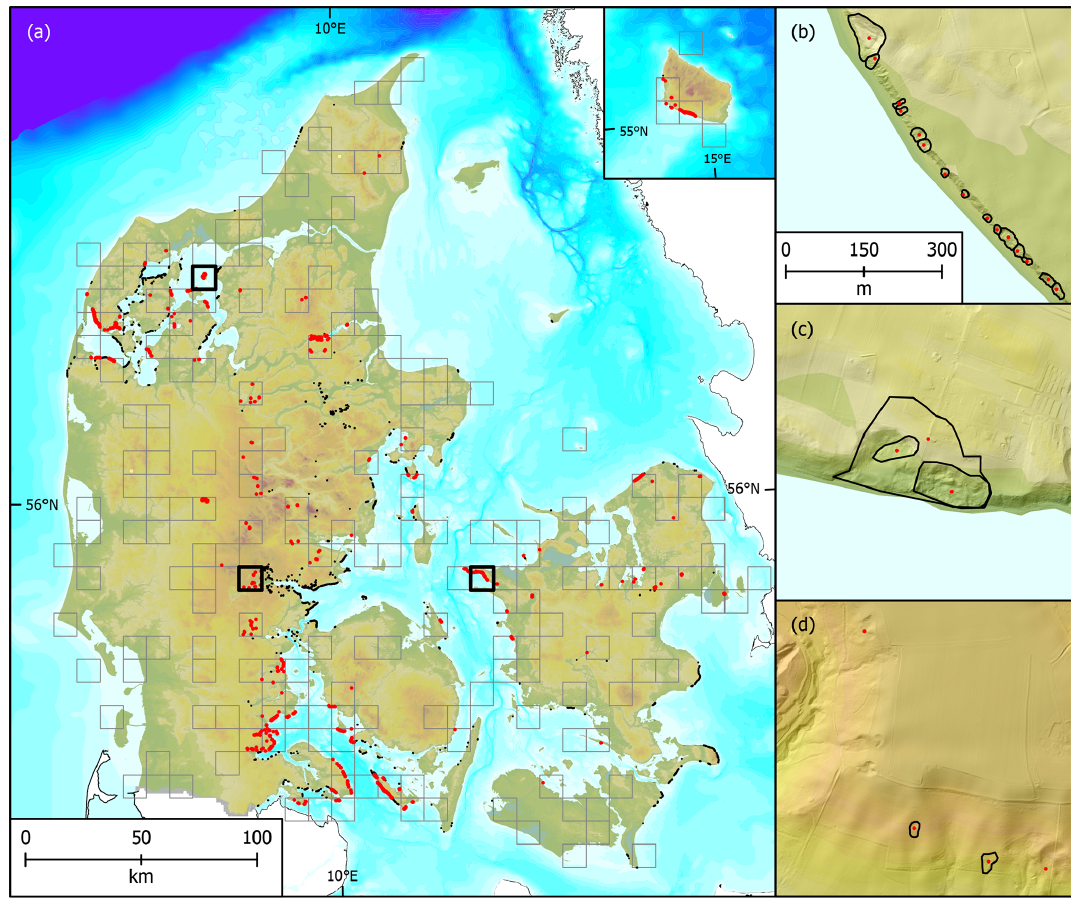
Figure 4. Landslide inventory quality control with 192 randomly selected tiles across Denmark. The black dots show the 1057 landslides mapped by the third mapper (a) , sequence of mapped landslide polygons along the coast with a high accordance of quality control points (b) , nested landslides with quality control points for each polygon (c) and mapped inland landslides with quality control points that show addi- tional landslides that were missed by the initial mappers (d)